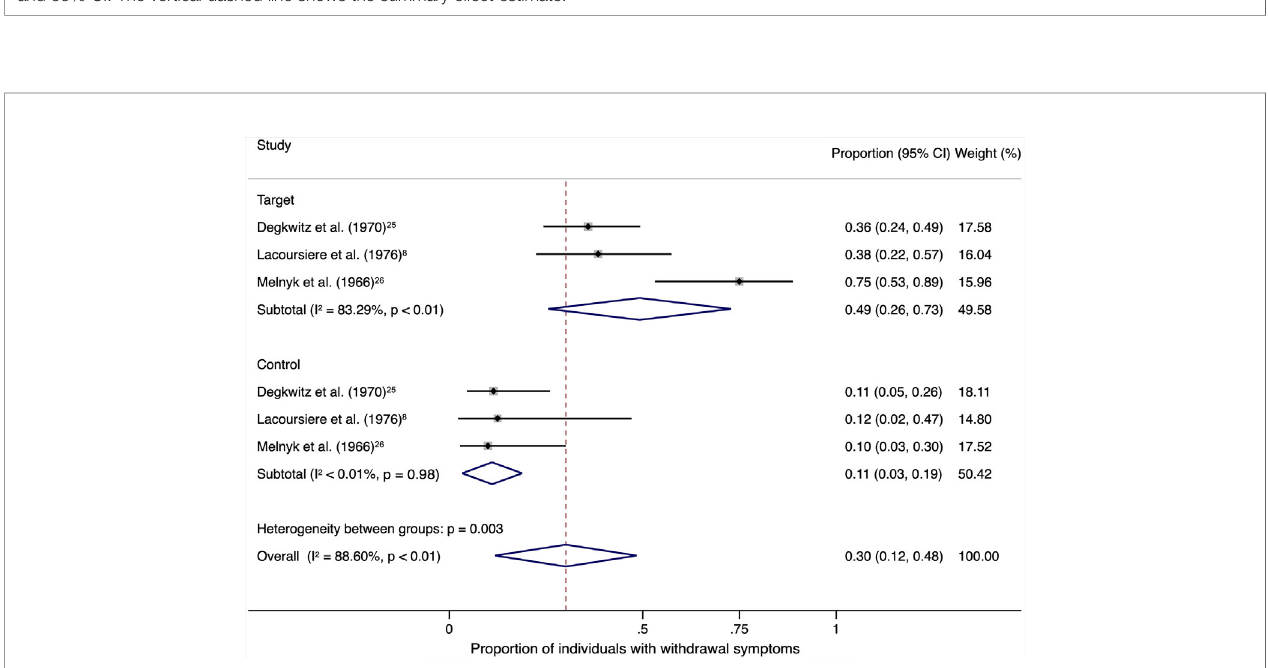
FIGURE 2 | The square data markers indicate the proportion of individuals with withdrawal symptoms in each study, with sizes re fl ecting the statistical weight of the study using random-effects meta-analysis of proportions. The horizontal lines indicate 95% CIs. The blue diamond data marker represents the subtotal and overall proportion and 95% CI. The vertical dashed line shows the overall effect estimate for both target and control